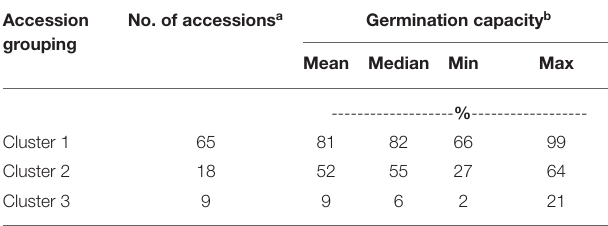
TABLE 4 | Germination capacity of Echinochloa species E. colona, E. crus-galli , and E. muricata from Arkansas, USA, averaged across accessions in a